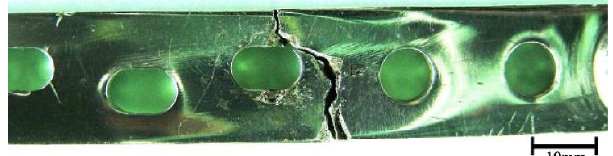
Figure 27. Top view of the fitted fractured mates of a stainless steel plate after ultrasonic cleaning [327]. Reprinted with permission from Elsevier.